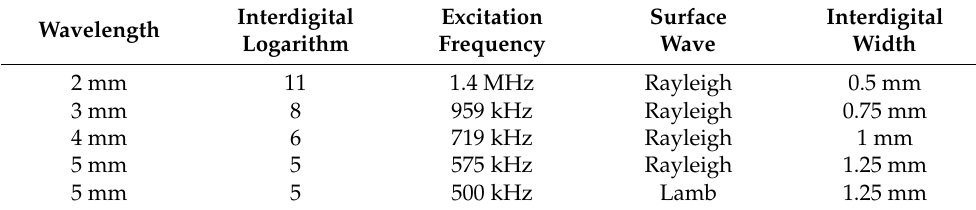
Table 1. Interdigital transducer and titanium alloy parameters. Wavelength